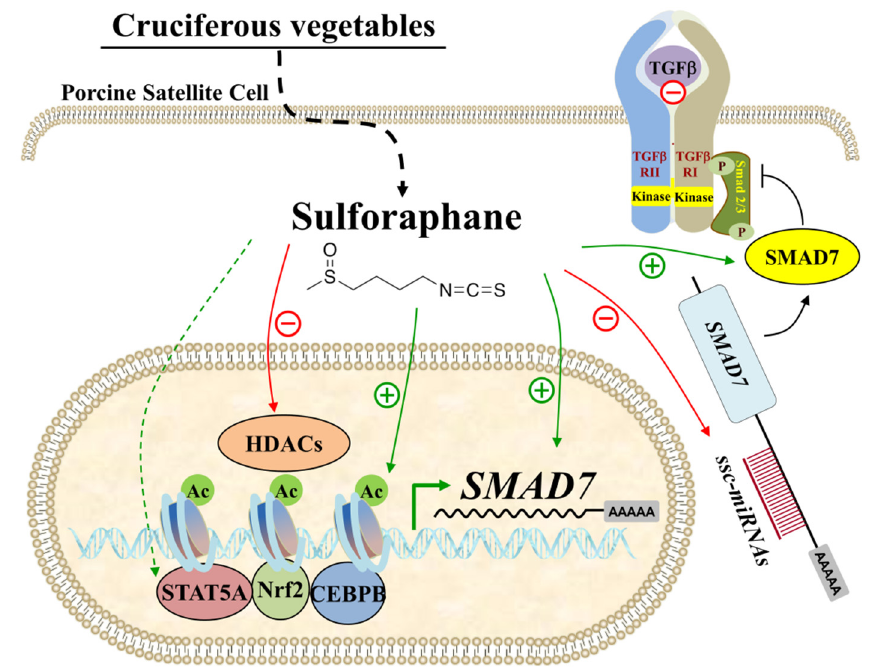
Figure 7. SFN upregulated SMAD7 expression in PSCs. SFN enriched the histone H4 acetylation level in the SMAD7 promoter and suppressed the expression of miRNAs targeting SMAD7, which led to increased mRNA and protein abundance of SMAD7 in PSCs.